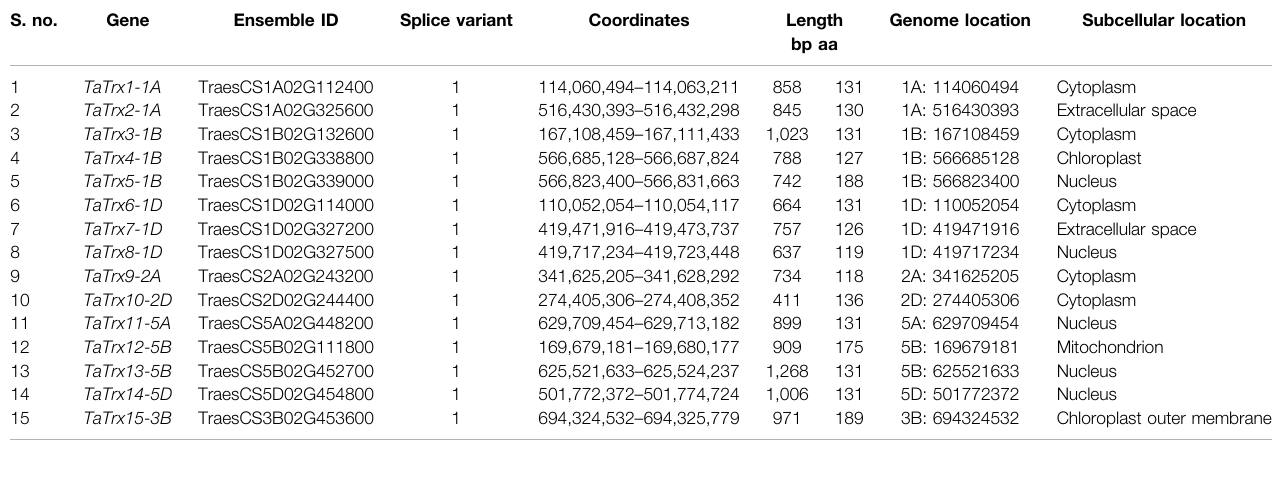
TABLE 1 | Details of selected TaTrx genes in wheat genome along with their subcellular locations.